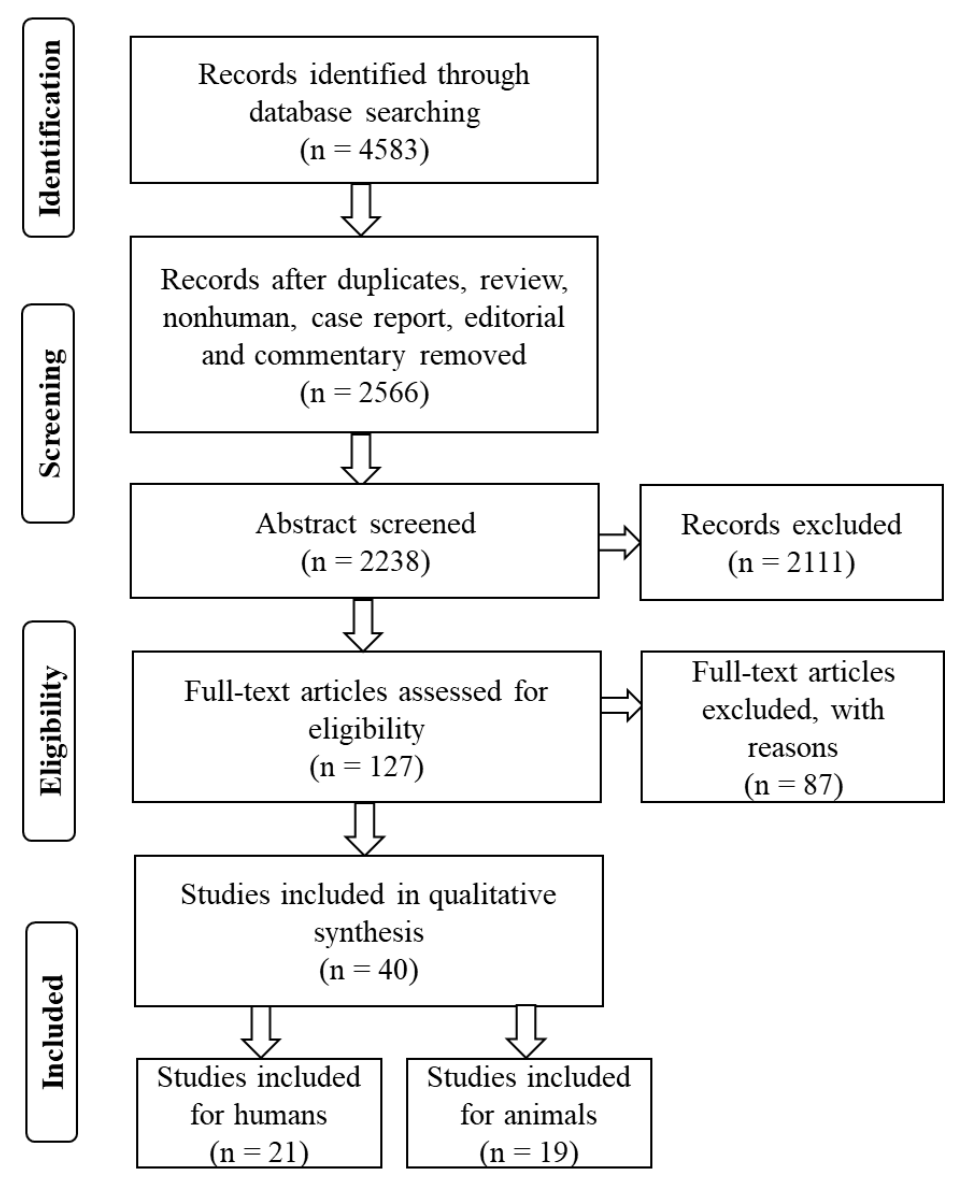
Figure 1. Flowchart of the systematic review.